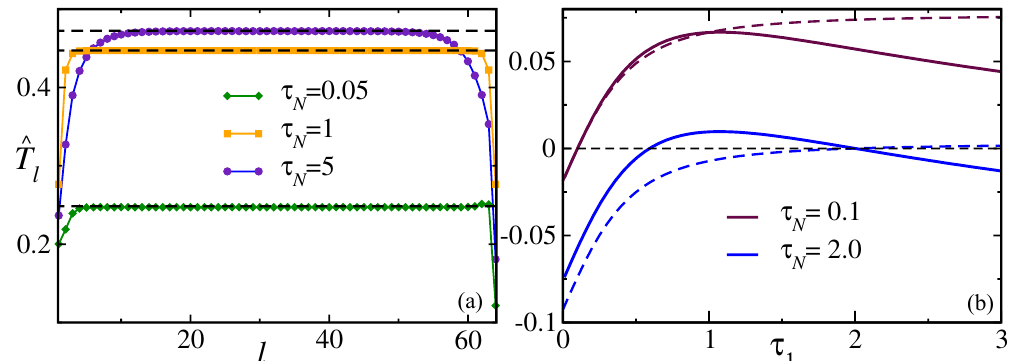
= 1 and different values Figure 5: (a) The kinectic temperature profile ˆ T for τ l 1 of τ measured from simulations with a chain of N = 64 oscillators driven by N the active noises (3). The dashed black lines show the predicted bulk temperature (7). (b) Comparison of J (solid lines) with the expected current for ‘effective’ act − T temperature gradient T (dashed lines) for two different values of τ . Here N N 1 = a = m = 1, k = 1, γ = 1 and a N 1